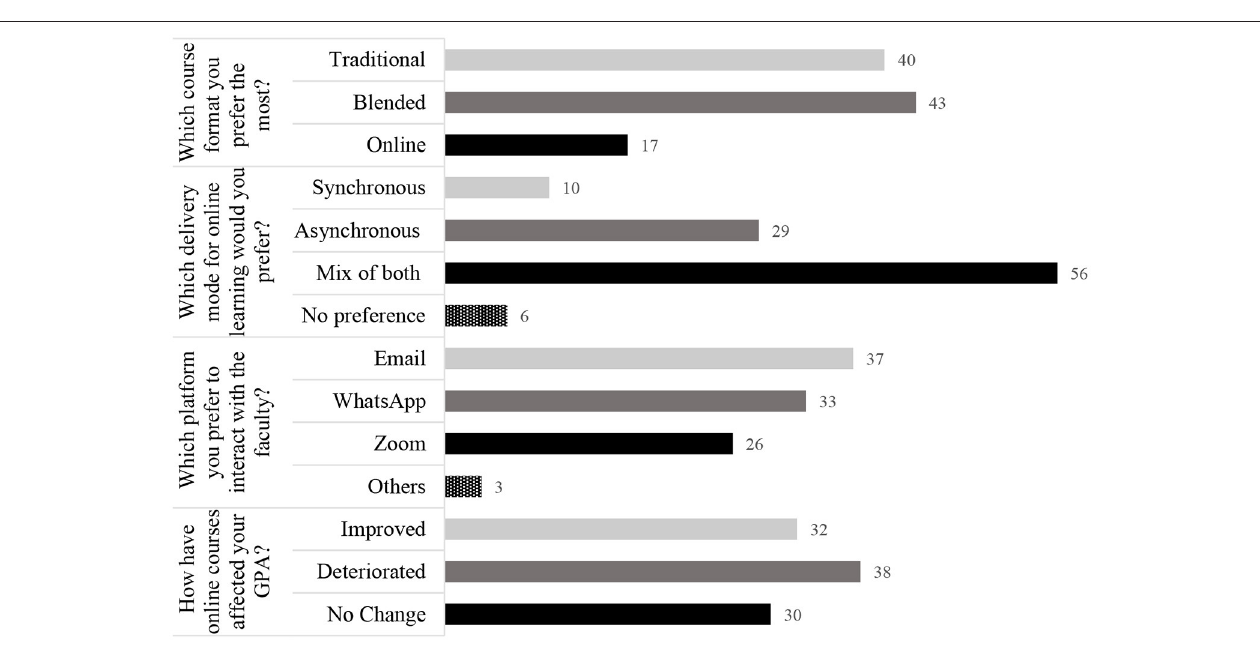
FIGURE 1 | “Students” preferences for key components of course formats and self-reported effect on GPA ( N = 209). GPA: grade point average. Data are shown as a percent (rounded-off to whole